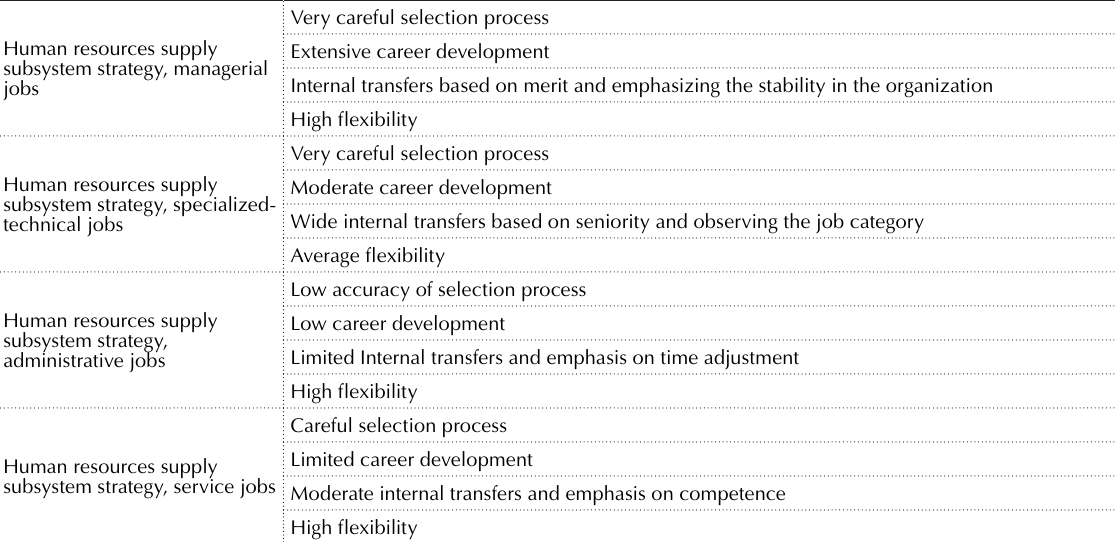
Table 9. The strategies of human resource supply subsystem jobs in the Civil Deputy of the Isfahan Municipality